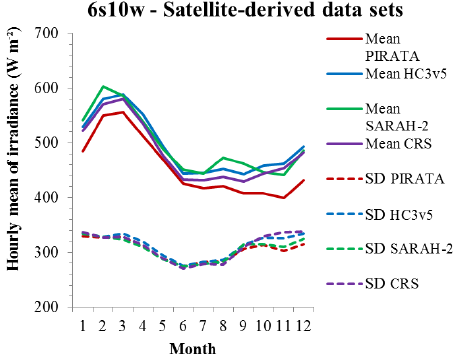
Figure 4. Monthly means (solid lines) and standard deviations (dot- ted lines) of hourly DSIS, in Wm − 2 , from PIRATA measurements (red) and data sets (HC3v5: blue; SARAH-2: green; CRS: purple) at 6 ◦ S, 10 ◦ W. A difference between red line (measurements) and coloured line (data set) for a given month denotes a systematic er- ror for this month: underestimation if the coloured line is below the red line, overestimation otherwise. For a given month, a coloured dotted line above the red one means that the data set produces too much variability for this month; in the opposite case, the data set does not contain enough